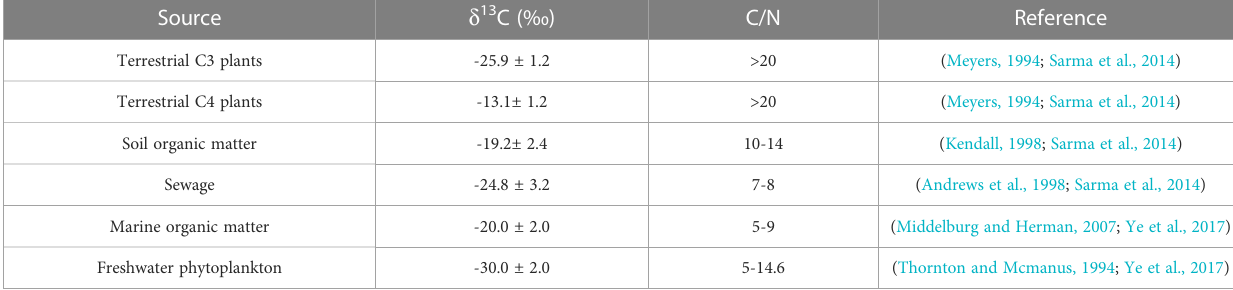
TABLE 1 The end-member values of d 13 C POC and C/N for the potential POM sources used in this study.